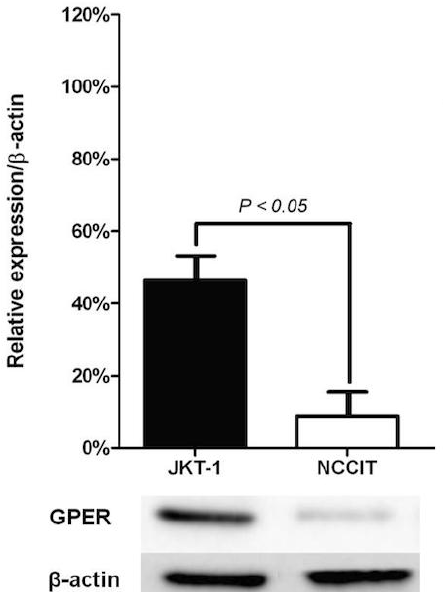
Figure 4. Relative expression of GPER protein (Western blotting) in human malignant testicular germ cell lines (JKT-1, a human testicular seminoma-derived cell line; NCCIT, a human testicular embryonic carcinoma cell line). Results are expressed as means ± standard error of the mean (SEM) of three different experiments; β-actin was taken in each case as a house-keeping